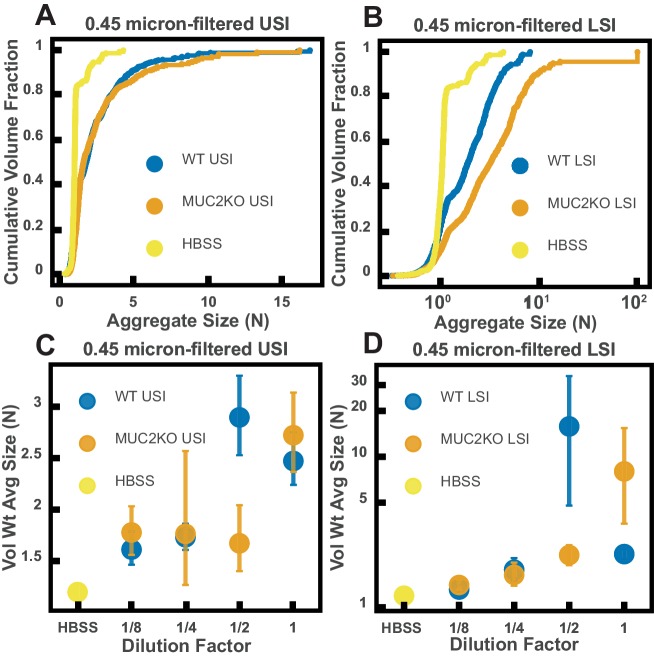
Ex vivo aggregation in 0.45 µm-filtered luminal fluid from the small intestines (SI) of wild-type (WT) and MUC2 knockout (MUC2KO) mice.(A and B) Volume-weighted empirical cumulative distribution functions (ECDFs) comparing aggregation of the particles in undiluted, 0.45-µm-filtered samples from the upper (A) and lower (B) SI of two separate groups of WT and MUC2KO mice to the control (particles suspended in HBSS). The vertical axis is the cumulative volume fraction of the total number of particles in solution in an aggregate of a given size. The horizontal axis is aggregate size in number of particles per aggregate (N). (C and D) Volume-weighted average aggregate sizes (Vol Wt Avg Size) for serial dilutions of 0.45 µm-filtered samples from the upper (C) and lower (D) SI of two separate groups of WT and MUC2KO mice. Volume-weighted average sizes are plotted on the vertical axis in terms of number of particles per aggregate (N). The dilution factor is plotted on the horizontal axis, where a dilution factor of 1 is undiluted and ½ is a two-fold dilution. The control (particles suspended in HBSS) is plotted as a dilution factor of 0. The vertical error bars are 95% empirical bootstrap CI using the bootstrapping procedure described in Materials and methods.